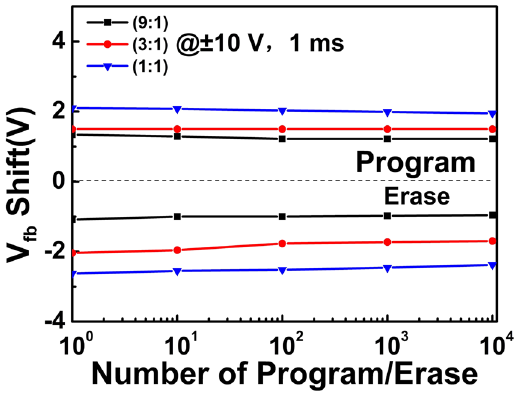
Figure 5. The endurance properties of TTO(9:1), TTO(3:1) and TTO(1:1) CTM